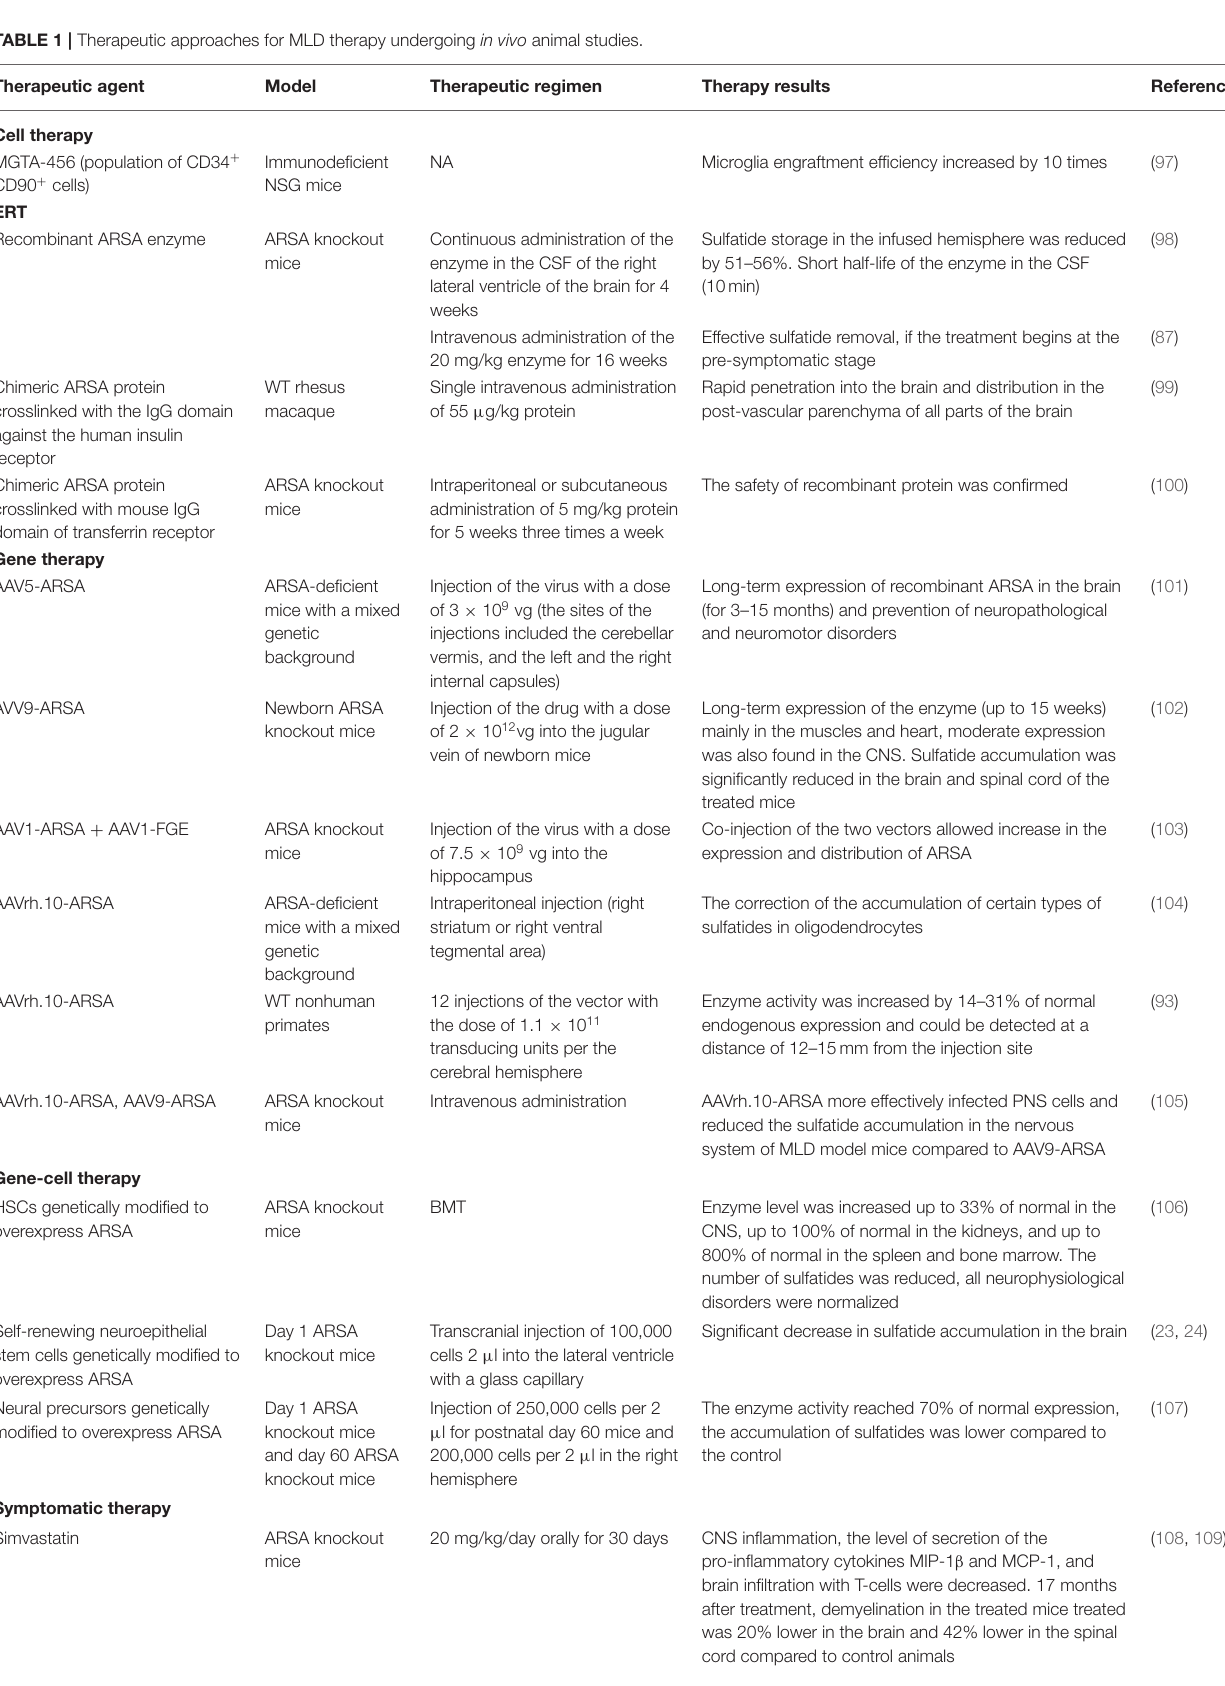
TABLE 1 | Therapeutic approaches for MLD therapy undergoing in vivo animal